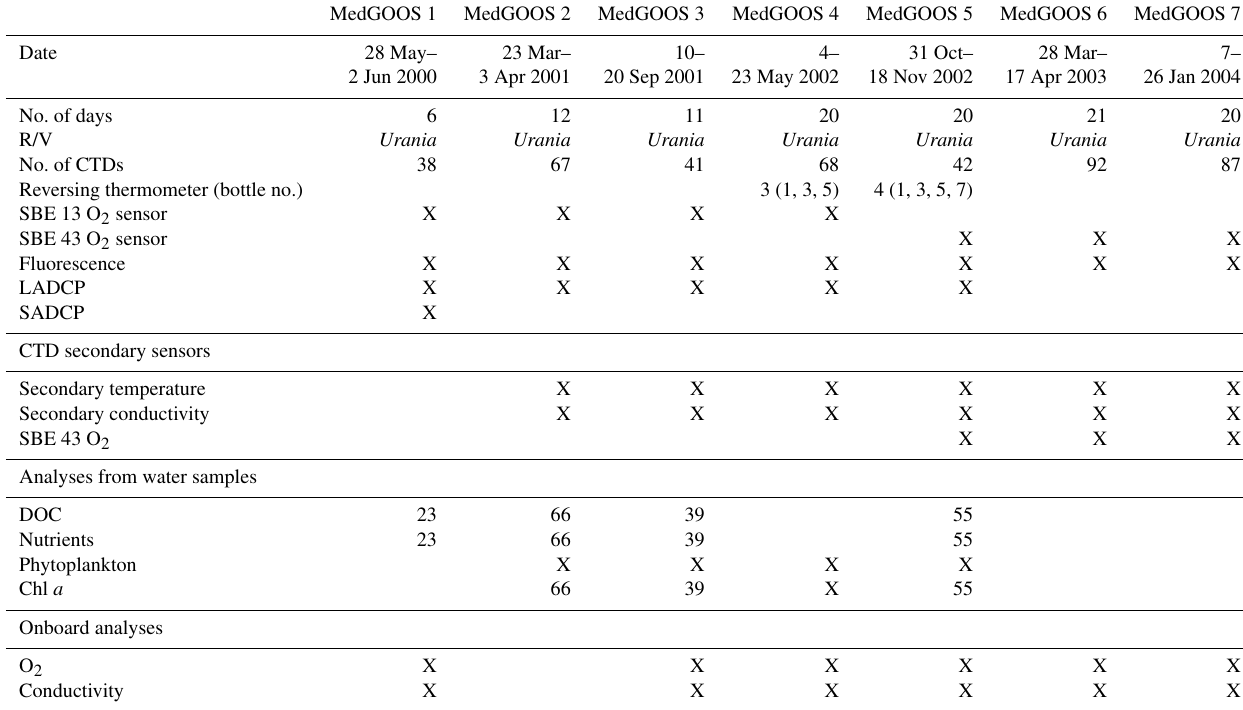
Table 1. The list of sensors used and activities realized during the seven MedGOOS cruises. Numbers in brackets for reversing thermometers are the numbers of the Niskin bottles where